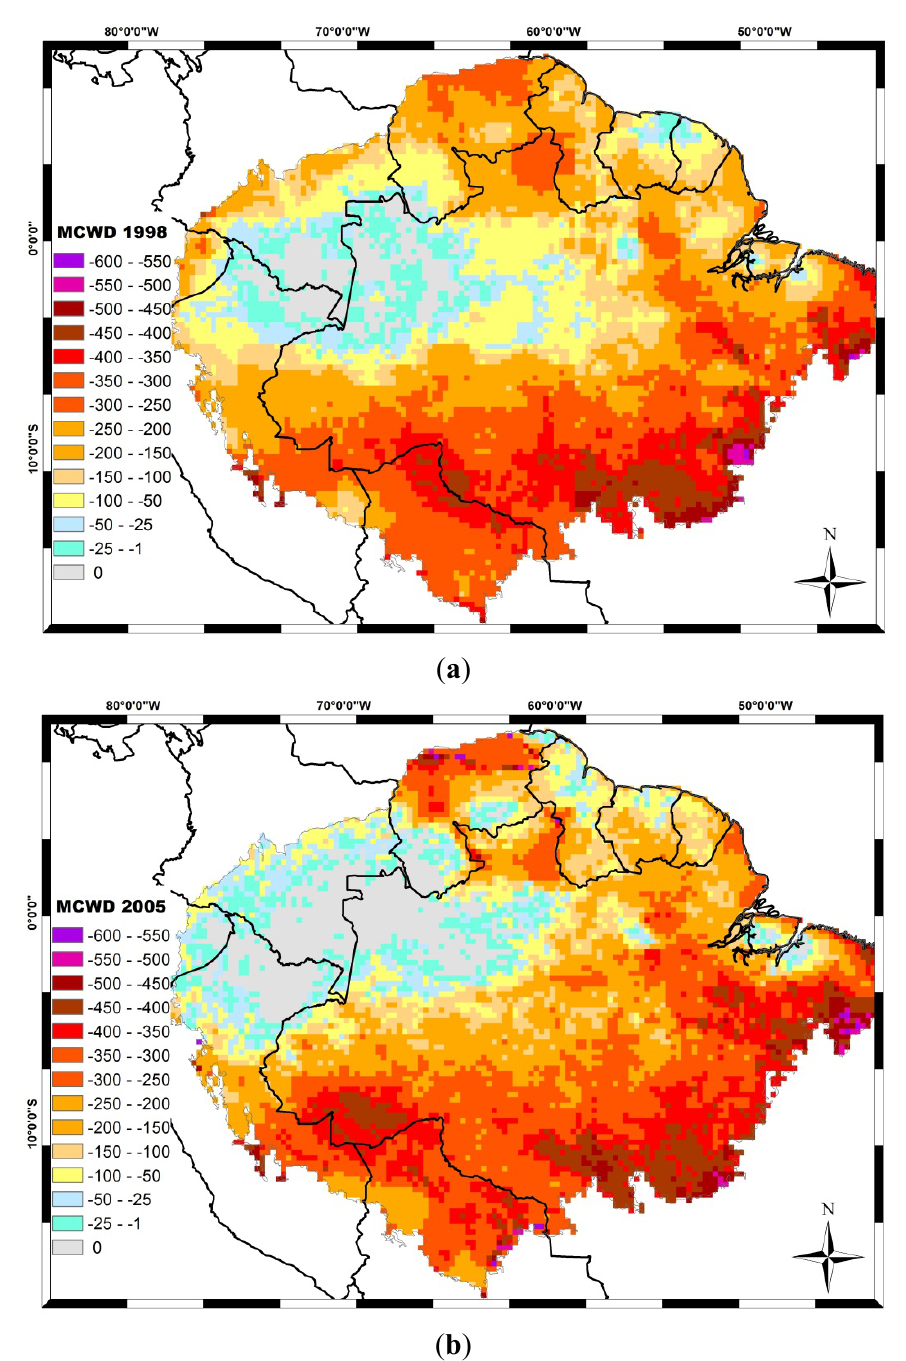
Figure 4. Drought severity can be measured by the maximum cumulative water deficit (MCWD), which corresponds to the maximum value of the accumulated water deficit (WD) that reached each area within a period of time. The WD is estimated based on the approximation that moist tropical forests transpires 100 mm·month − 1 , and therefore, when rainfall is lower than 100 mm·month − 1 , the forest is considered under water stress. Areas that experienced more severe droughts present lower MCWD values. Spatial distribution of the MCWD between January and December ( a ) 1998; ( b ) 2005; and ( c ) 2010. Data